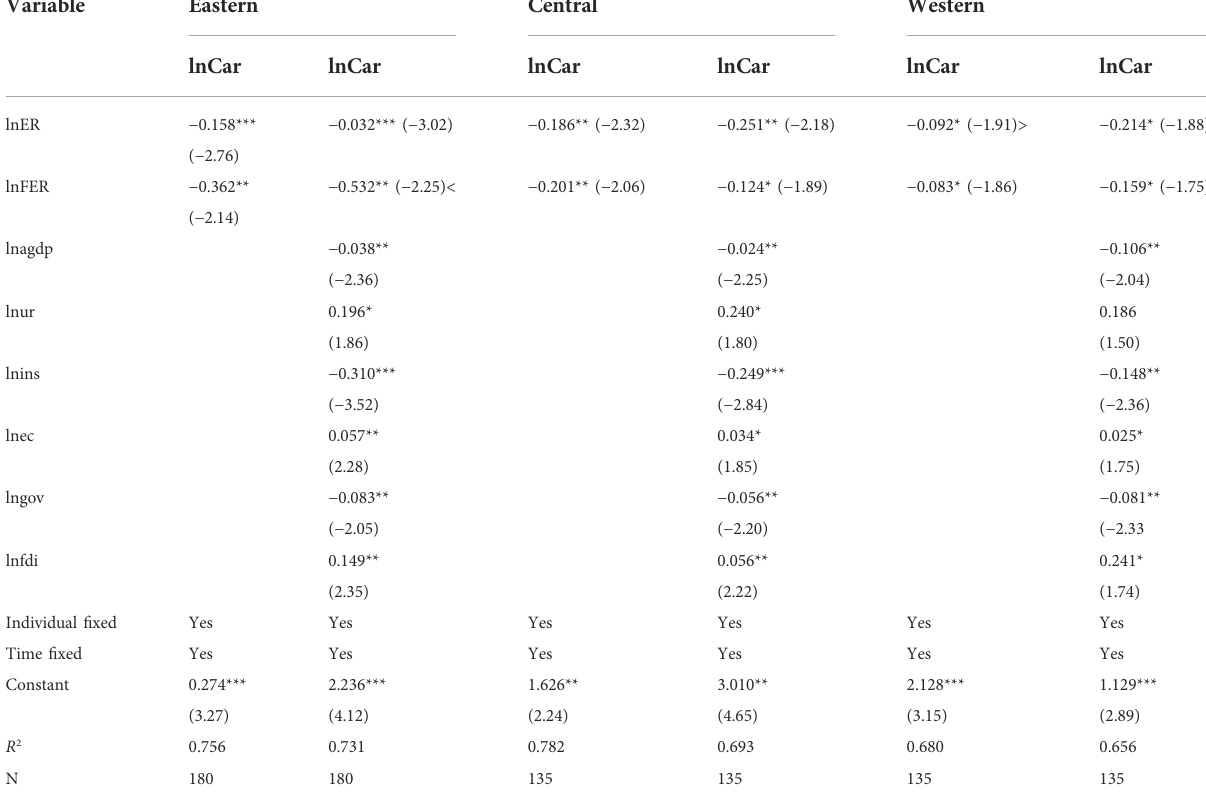
TABLE 4 Regression results of the impact of different levels of economic development. Variable